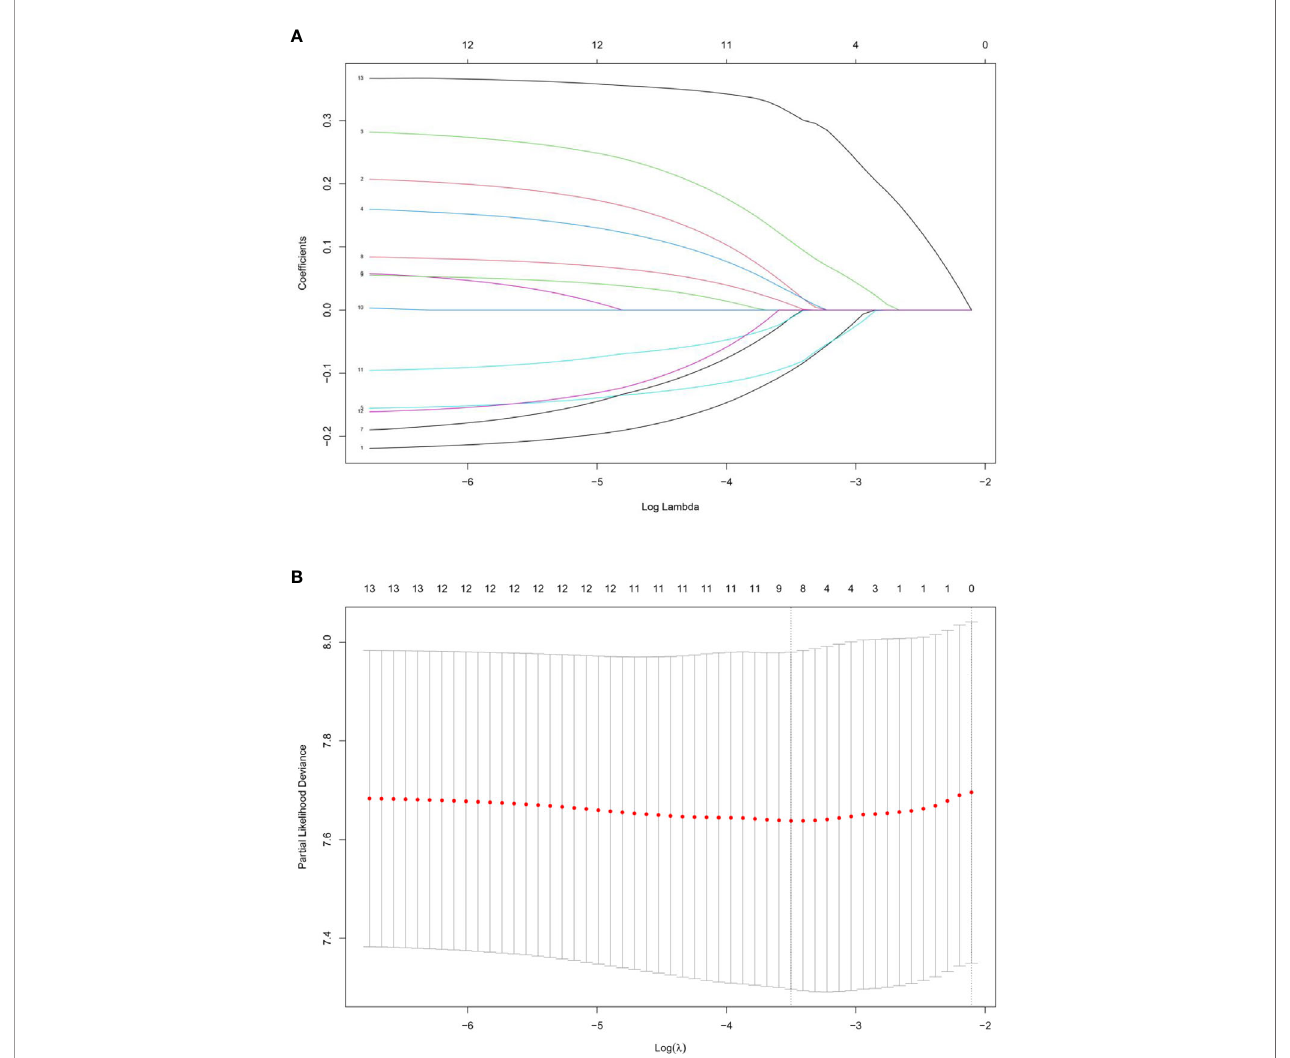
FIGURE 1 | (A) LASSO coef fi cient pro fi les of the selected IHC markers. (B) The tuning parameter ( l ) selection used 10 ‐ fold cross ‐ validation via minimum criteria. Partial likelihood deviance was plotted versus log( l